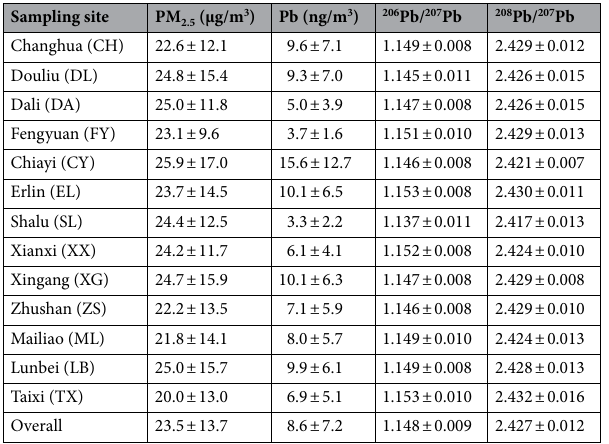
Table 1. Summary of the average concentrations of PM 2.5 and Pb associated with Pb-isotopic composition during the intensive field investigation.